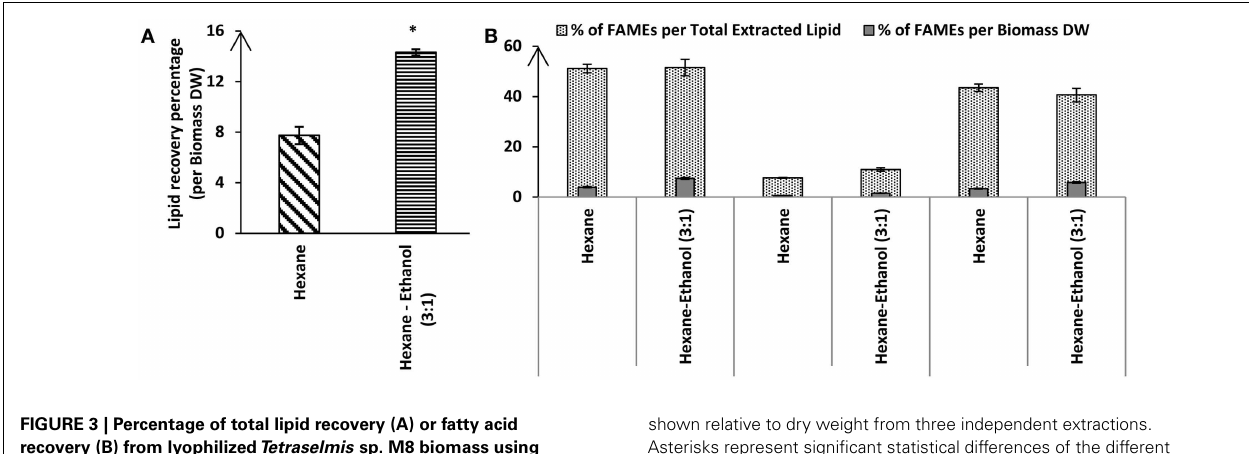
FIGURE 3 | Percentage of total lipid recovery (A) or fatty acid recovery (B) from lyophilized Tetraselmis sp. M8 biomass using hexane or hexane–ethanol (3:1) Soxhlet extraction . All values are